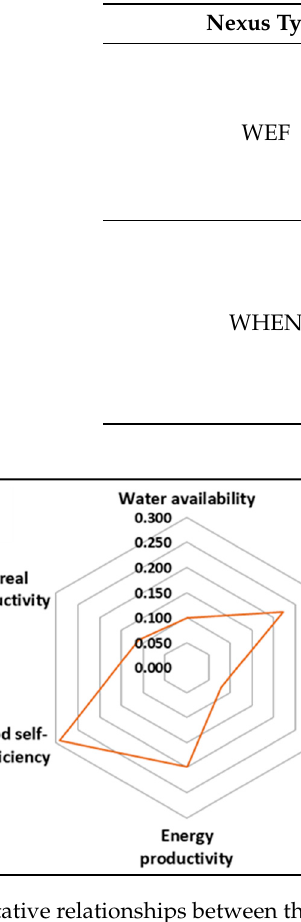
Figure 2. Quantitative relationships between the indicators representing the WEF nexus ( a ) and the WHEN nexus ( b ) in South Africa in 2015.